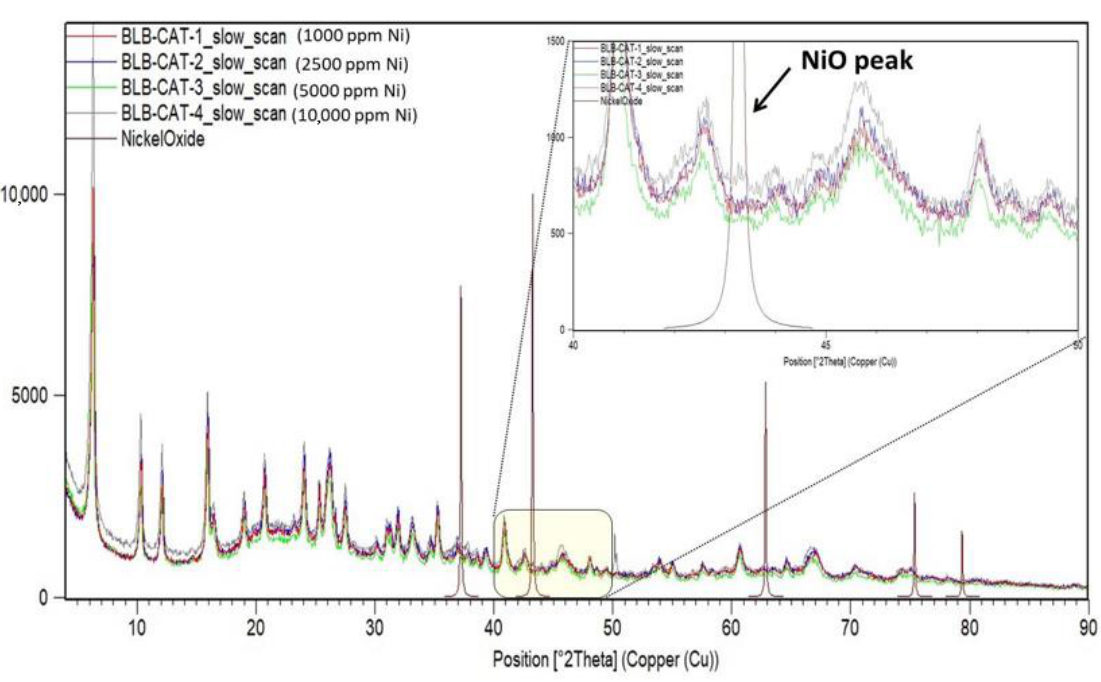
Figure 8. PXRD patterns of BLB-CAT-x samples which are industrial boron-containing FCC catalysts loaded with increasing amounts of Ni and deactivated in the lab following typical cyclic propylene steaming (CPS) deactivation protocols. The pattern of NiO is also included for comparison, while the inset figure focuses on the 2 θ region of 40 to 50°, which includes the most prominent reflection of NiO, i.e., (2 0 0) at ~43.3°.